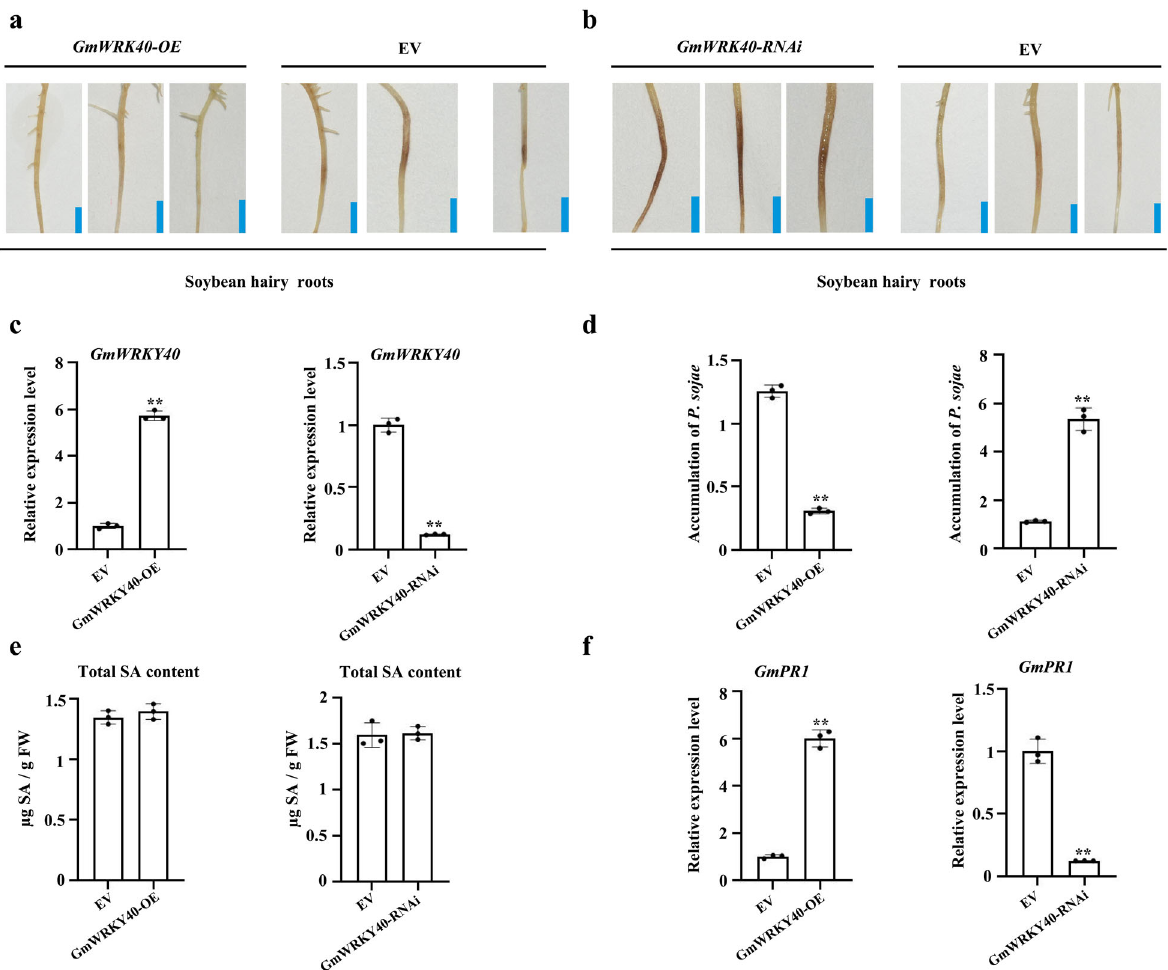
Fig. 5 GmWRKY40 also functions downstream of SA biosynthesis and enhances the expression of SA-marker gene GmPR1 in response to P. sojae . a Typical phenotypes of WRKY40-OE and EV soybean hairy roots after 48 h of P. sojae inoculation. Bars, 0.5 cm. b Typical phenotypes of WRKY40-RNAi and EV soybean hairy roots after 48 h of P. sojae inoculation. Bars, 0.5 cm. c qRT-PCR analysis of relative GmLHP1 expression in transgenic soybean hairy roots. Soybean hairy roots transformed with empty vector (EV) were used as controls; the expression level of the control sample (EV) was set to 1. d Relative biomass of P. sojae in GmLHP1- transgenic soybean hairy roots based on the transcript level of P. sojae TEF1 (EU079791). e SA contents in WRKY40-OE , WRKY40-RNAi , and EV hairy roots. FW, fresh weight. f Relative expression level of GmPR1 in WRKY40-OE , WRKY40-RNAi , and EV hairy roots. The expression level of the control sample (EV) was set to 1. The housekeeping gene GmEF1 was used as an internal control to normalize the data. The experiment was performed on three biological replicates, each with three technical replicates, and the results were statistically analyzed using Student ’ s t -test (* P < 0.05, ** P < 0.01). Bars indicate the standard deviation of the mean ( n =